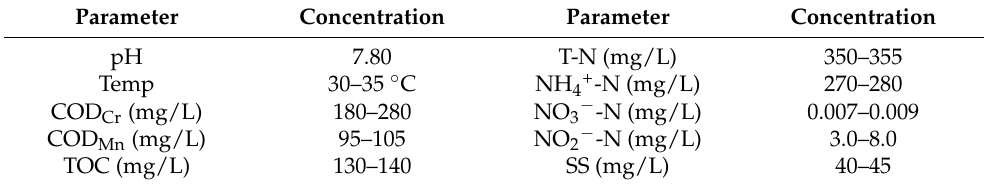
Table 2. Characteristics of